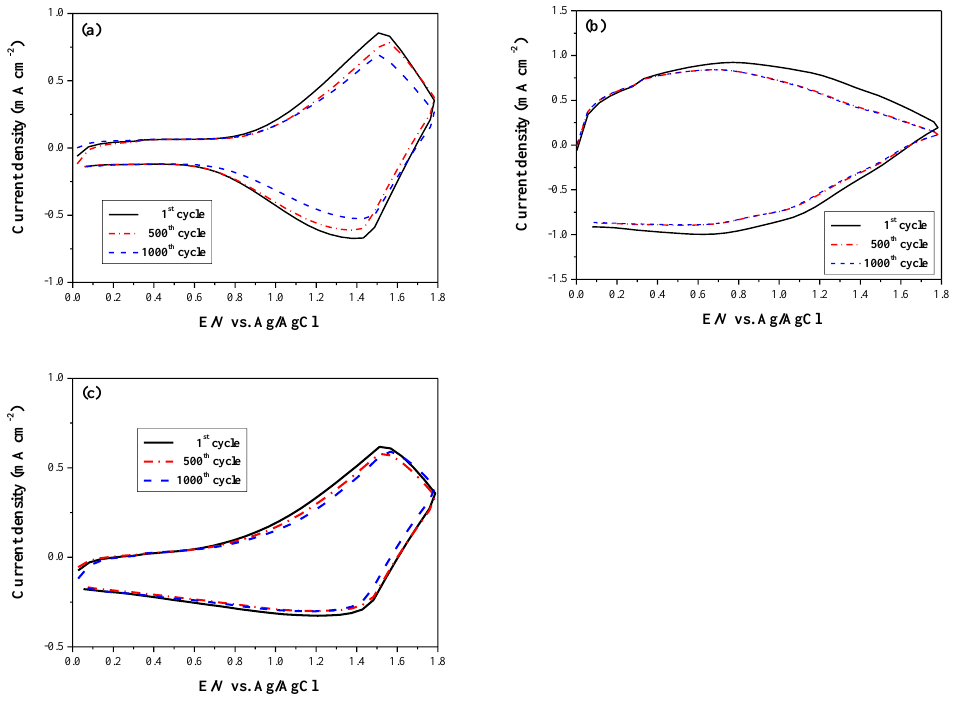
Figure 10. Cyclic voltammograms of ( a ) PDiCP/PEDOT-PSS; ( b ) P(DiCP- co -CPDT2)/PEDOT-PSS; and ( c ) P(DiCP- co -CPDTK)/PEDOT-PSS devices with a scan rate of 500 mV s − 1 at the first, 500 th , and 1000 th cycles.